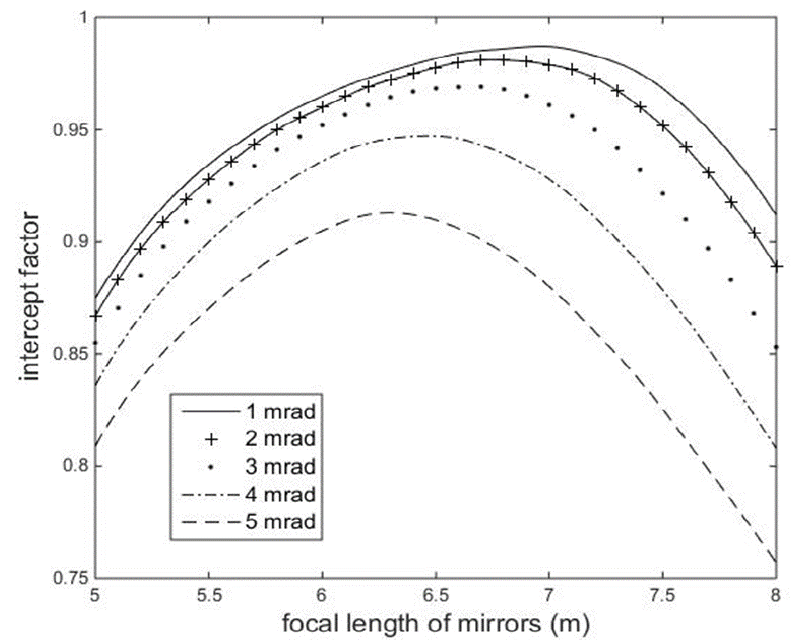
Figure 8. Variation of the system intercept factor with the mirror focal length under 1–5 mrad optical error, when the system focal length is 5 m and the radius of the receiver is 0.1 m.